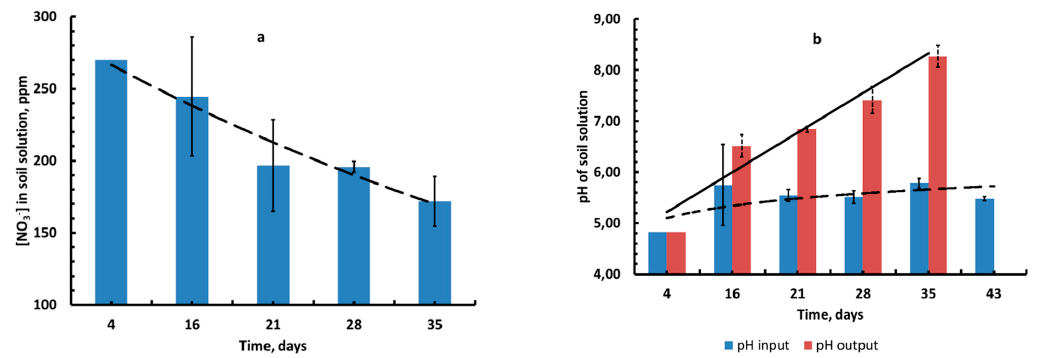
Figure 7. Concentration dynamics in soil solution (mean value ± standard deviation; n = 3): [NO 3 − ] ( a ) and pH ( b ). Data on the 4th day were derived from single extractions.